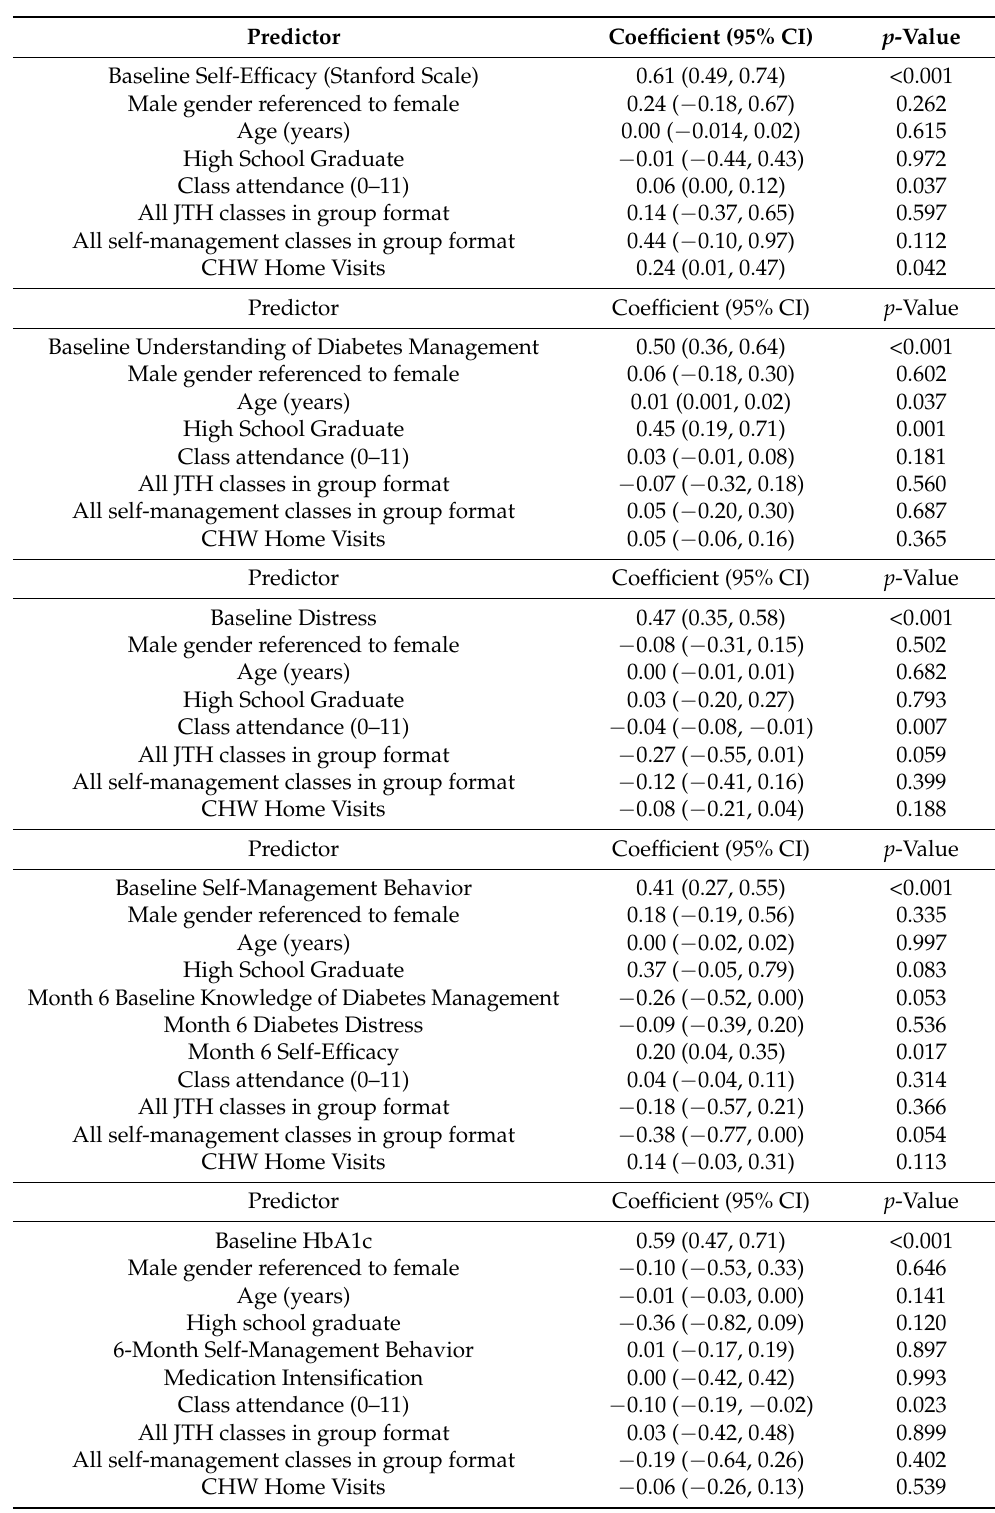
Table 2. a–e: Gender and Linear Regression on Cohort 3 Outcomes. a: 6-Month Self-Efficacy (Stanford Scale). R 2 = 0.423. b: 6-Month Understanding of Diabetes Management (Diabetes Care Profile). R 2 = 0.428. c: 6-Month Diabetes Distress. R 2 = 0.338. d: 6-Month Self-Management